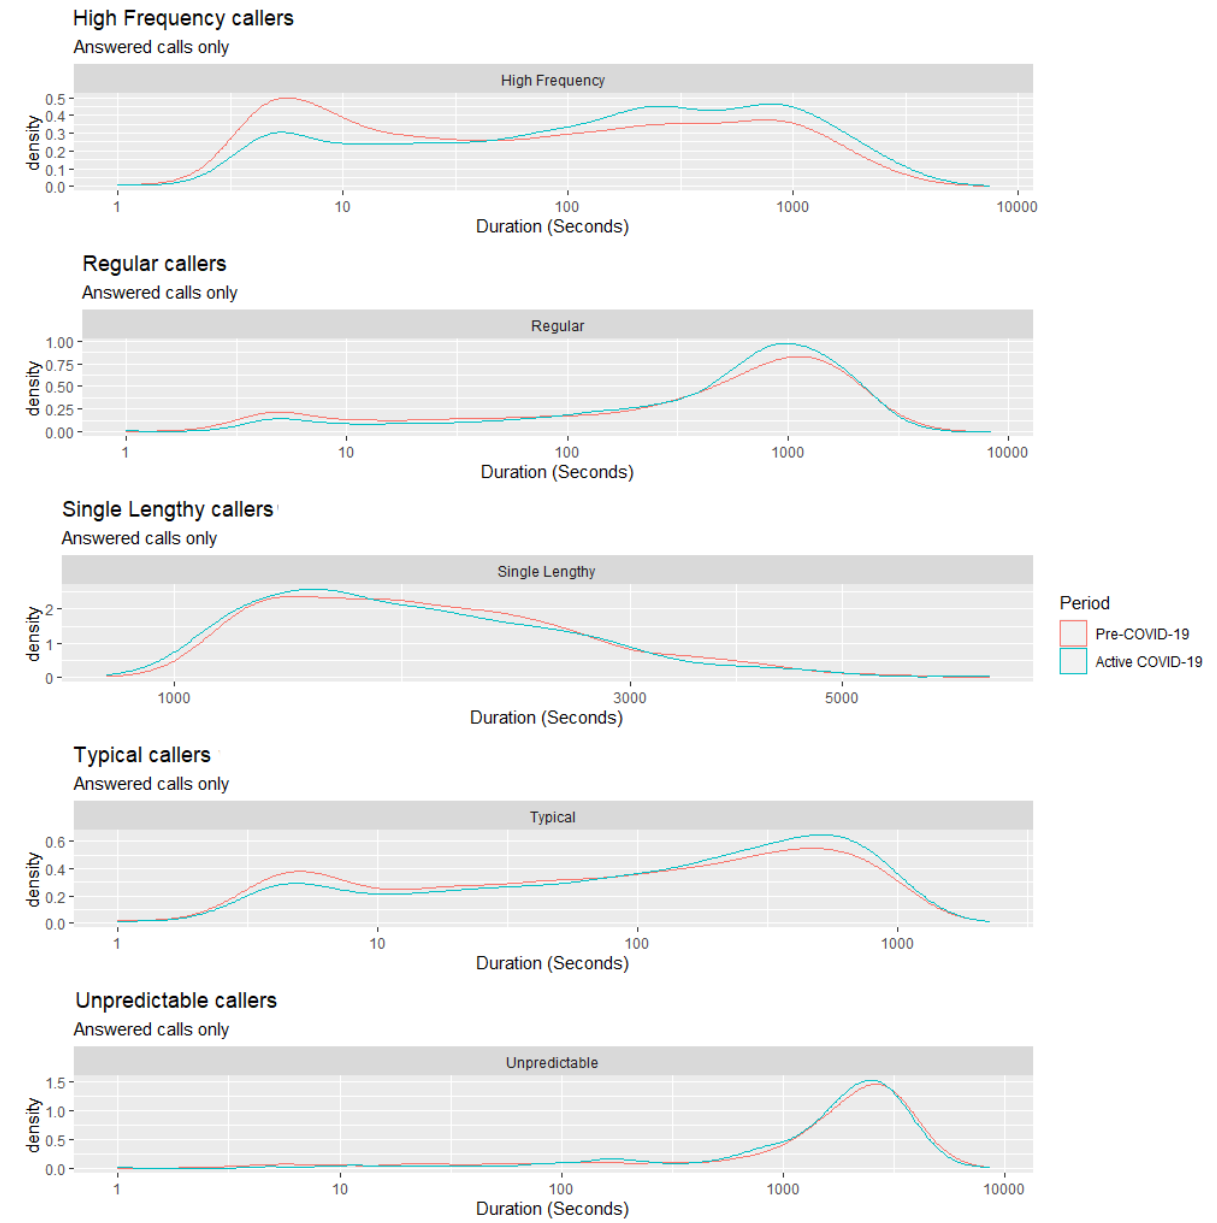
Figure 4. Densities of call durations for the five caller types from the Pre–COVID-19 period to the Active COVID-19